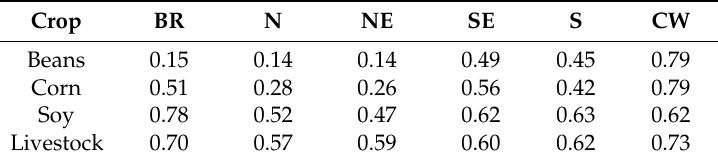
Table 3. Land Gini coefficient for beans, maize, soy, and livestock in 2006 for Brazil (BR) and its major geographical regions: N—North, NE—Northeast, SE—Southeast, S—South, CW—Center-West. Crop BR N NE SE S CW Beans